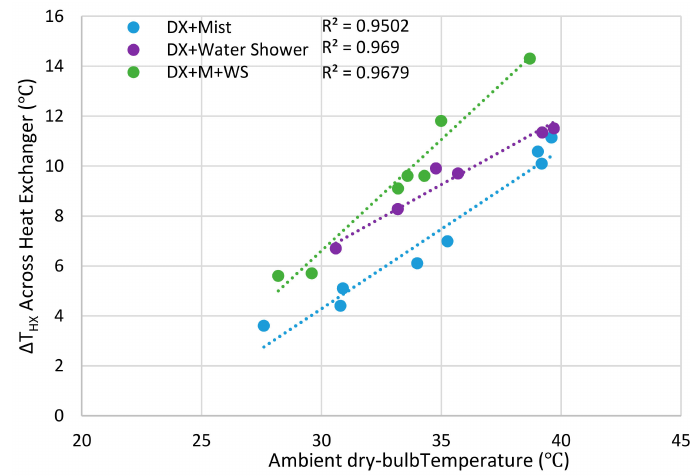
Figure 5. Variation of ∆ T HX across indirect evaporative cooling (IEC) heat exchanger with dry-bulb temperature for ambient temperatures less than 40 ◦ C.